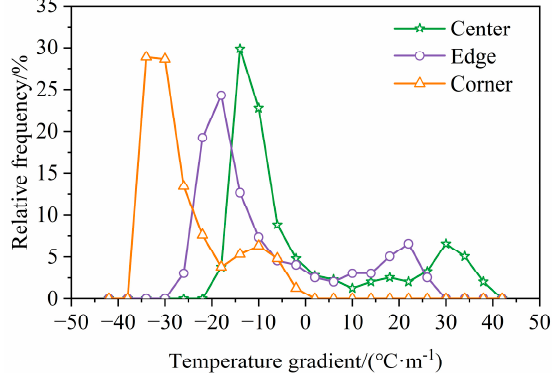
Figure 4. Temperature gradient time history curve of RCP.